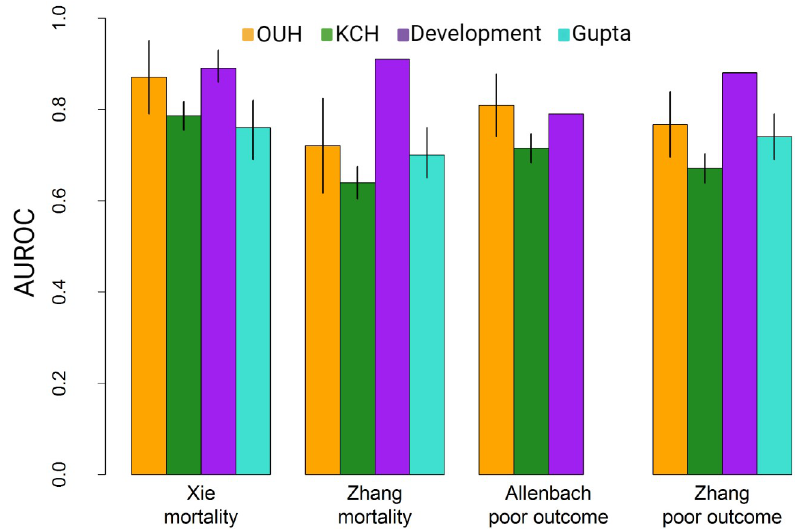
Fig 2. Discrimination of the models at the different sites. AUROCs from validation of the four models at the KCH and OUH cohorts, and the original AUROC from development cohorts [21–23]. Also shown are the results from the external validation of the Xie and Zhang models by Gupta et al. [6]. Lines represent the 95% CIs of the AUROCs. For the development cohorts only Xie reported confidence intervals.